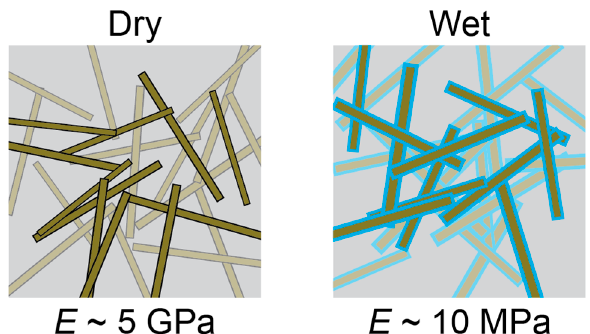
Figure 1. Schematic demonstrating the sea cucumber dermis-inspired PVAc-CNC softening mechanism. In the dry state ( left ), cellulose nanocrystals joined by hydrogen bonds form a reinforcing network throughout the nanocomposite. When saturated with water ( right ), the inter-nanocrystal hydrogen bonds are displaced with water molecule-nanocrystal bonds, leading to an overall reduction in storage modulus.